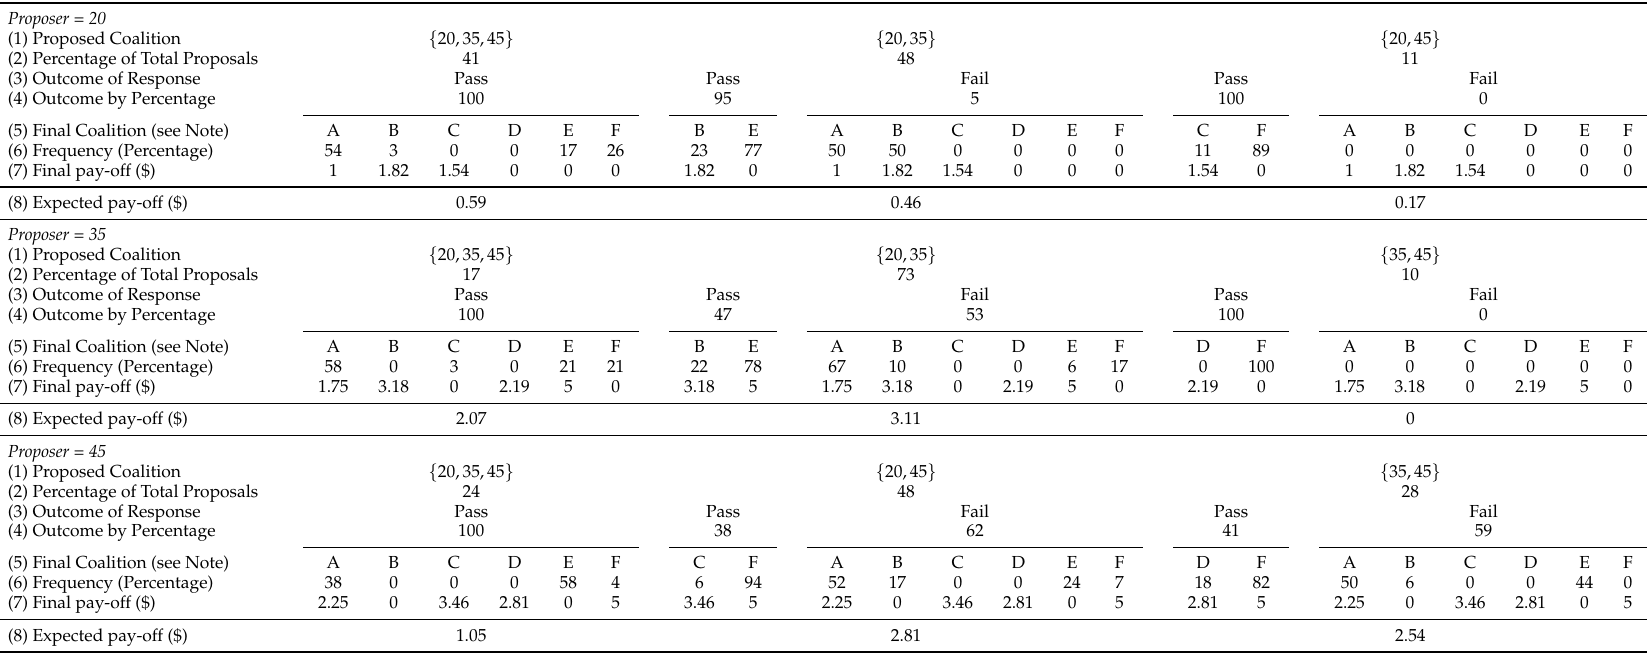
Table A2. Expected payoffs by proposal strategy for each power draw, early